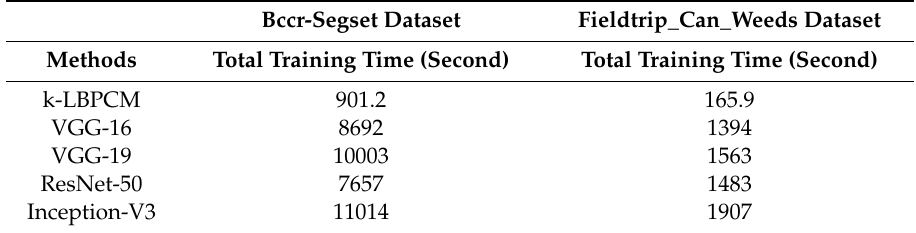
Table 9. Total training time of the k-FLBPCM and the VGG-16, VGG-19, ResNet-50 and Inception-V3 models for datasets in the laboratory and in the